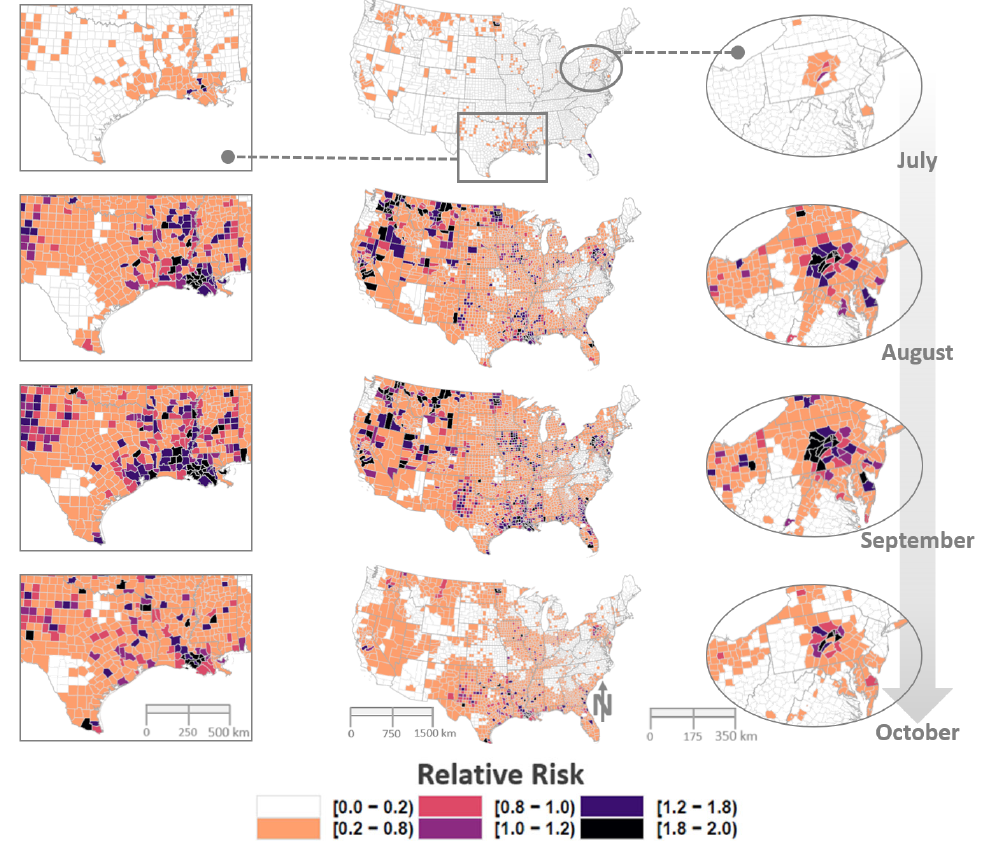
Figure 9. Spatiotemporal distribution of equine WND relative risk. Maps depict the spatial and temporal distribution of model estimated WND relative risk by US County for the months July– October. Column aligned at center displays the Contiguous US with lateral columns providing closer views of locations demarcated on US map at top center. Maps are color coded according to legend at bottom such that darker tones signify increased risk and lighter tones represent relatively lower